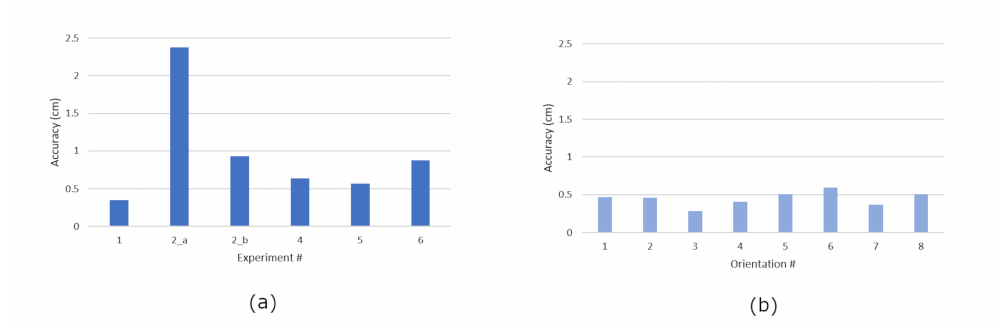
Figure 10. Accuracy graphs for all of the experiments performed on HTC Vive: ( a ) HTC Vive accuracy results. ( b ) Experiment #3 accuracy